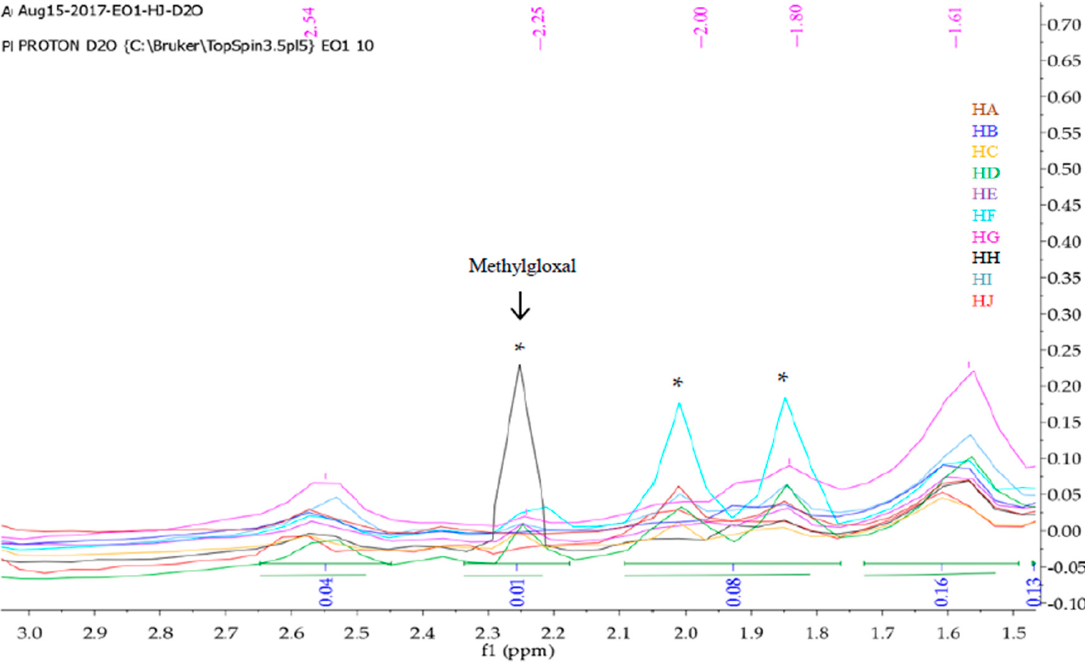
Figure 3. Fingerprints of superimposed and binned 1 H-NMR spectra in D 2 O at region 3.00–1.50 ppm, using Mnova 12 NMR software. * VIP chemical markers resonating at 1.80, 2.00, and 2.17 ppm.